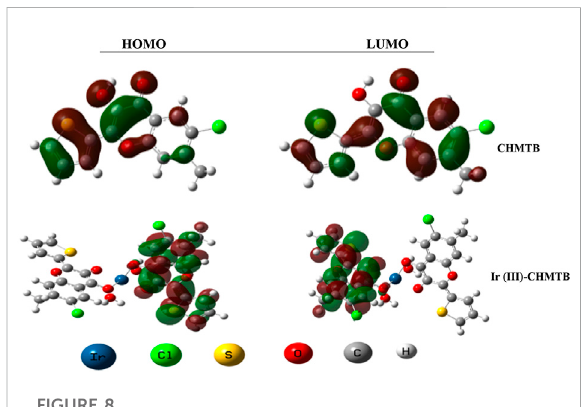
FIGURE 8 HOMO/LUMO outlines of CHMTB and its Ir (III) complex.